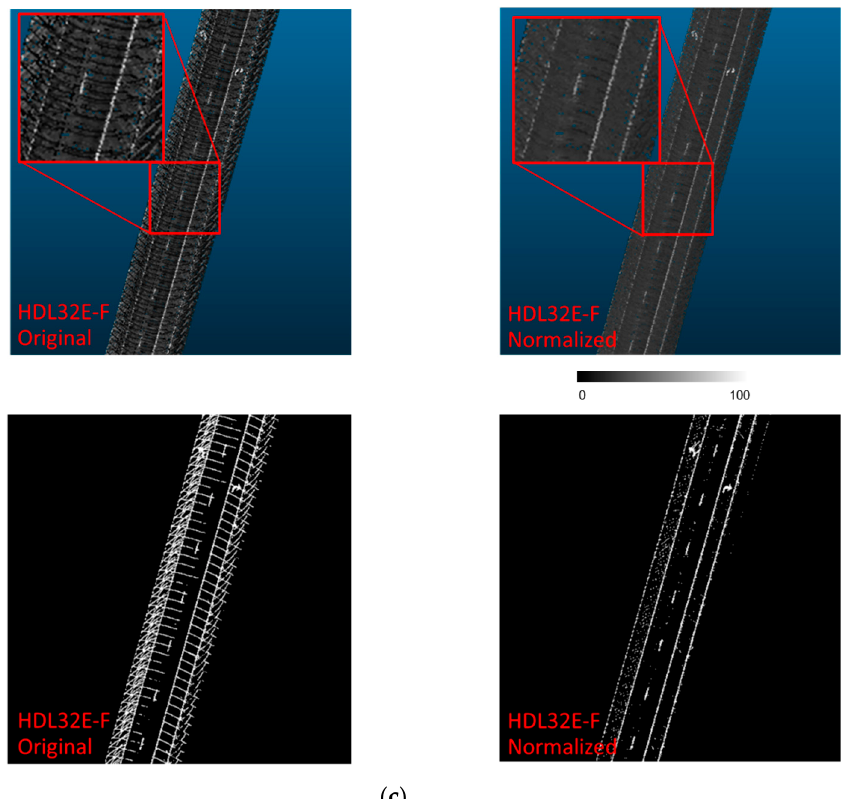
Figure 19. Intensity normalization maps associated with an HDL 32E LiDAR unit for ( a ) ROI 1, ( b ) ROI 2, and ( c ) ROI 3. Table 6. Experimental settings for training the U-net